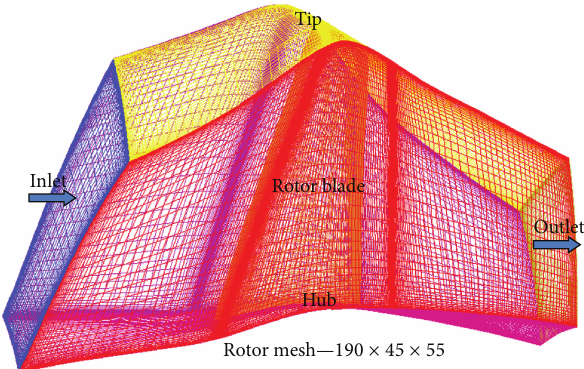
Figure 2: Computational grid across one rotor blade passage.